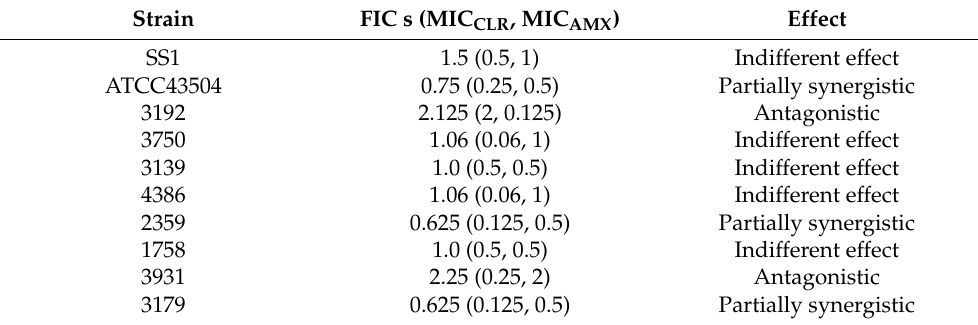
Table 3. Fractional inhibitory concentrations (FICs) of amoxicillin and clarithromycin on H. pylori